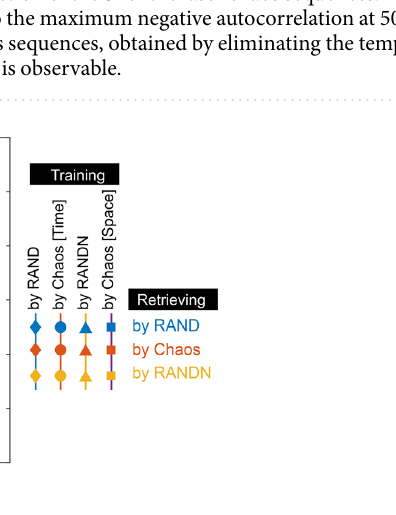
(2019) 9:12963 | https://doi.org/10.1038/s41598-019-49397-2